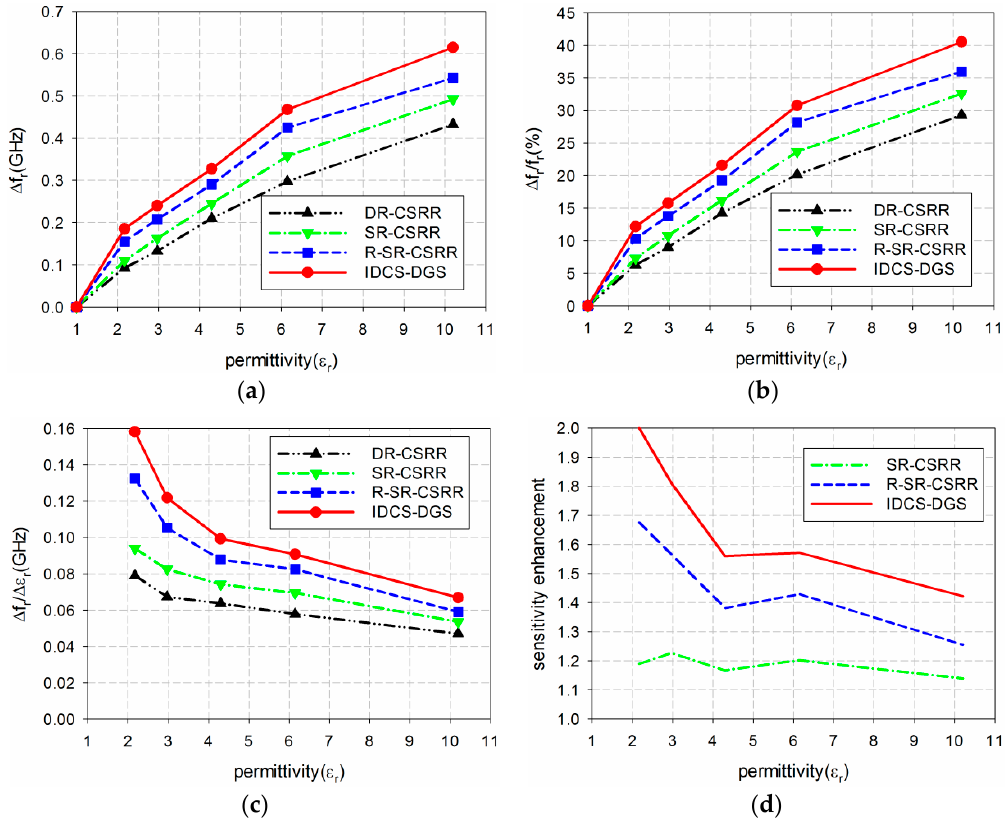
Figure 13. Measured sensitivity comparison of the four permittivity sensors: ( a ) frequency shift ( Δ f r (GHz)); ( b ) percent relative frequency shift ( Δ f r /f r (%)); ( c ) sensitivity ( Δ f r / Δ ε r (GHz)); ( d ) sensitivity enhancement compared to the DR-CSRR-based sensor.